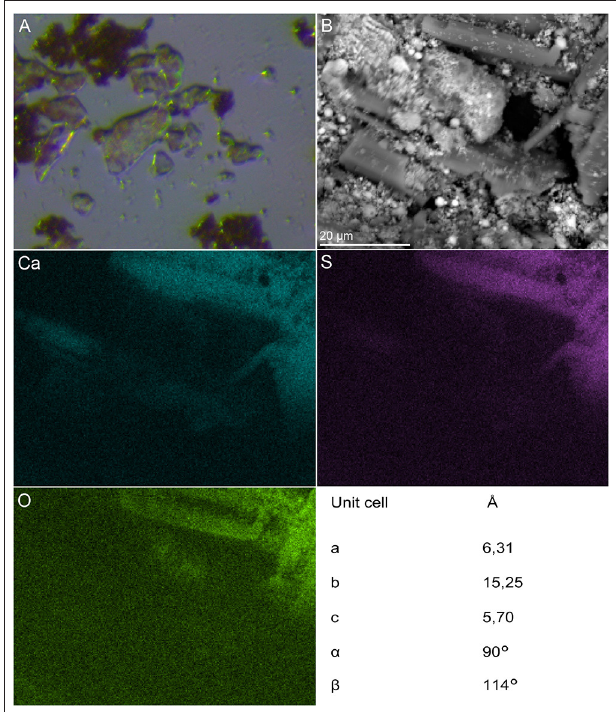
FIGURE 8 | Microscopic and spectroscopic analysis of gypsum crystals detected in A. manzaensis culture supplemented with BOF-dust. (A) Light microscopy of gypsum crystals in active culture. (B) SEM image of bioprocessed BOF-dust sample used for the EDS spectrum image acquisition and corresponding extracted calcium (Ca), sulfur (S), and oxygen (O) elemental maps with unit cell parameters detected with single-crystal X-ray diffraction (XRD)